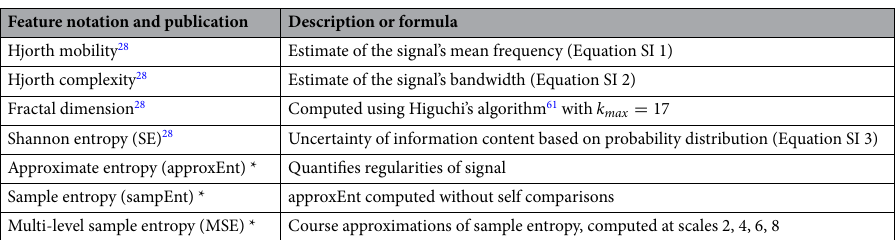
Table 3. Summary of features extracted from the ECG. * Indicates features that, to the authors’ knowledge, have not been previously implemented for BP estimation. Full details of the algorithms and equations used for computing each feature can be found in Supplementary Information SI: